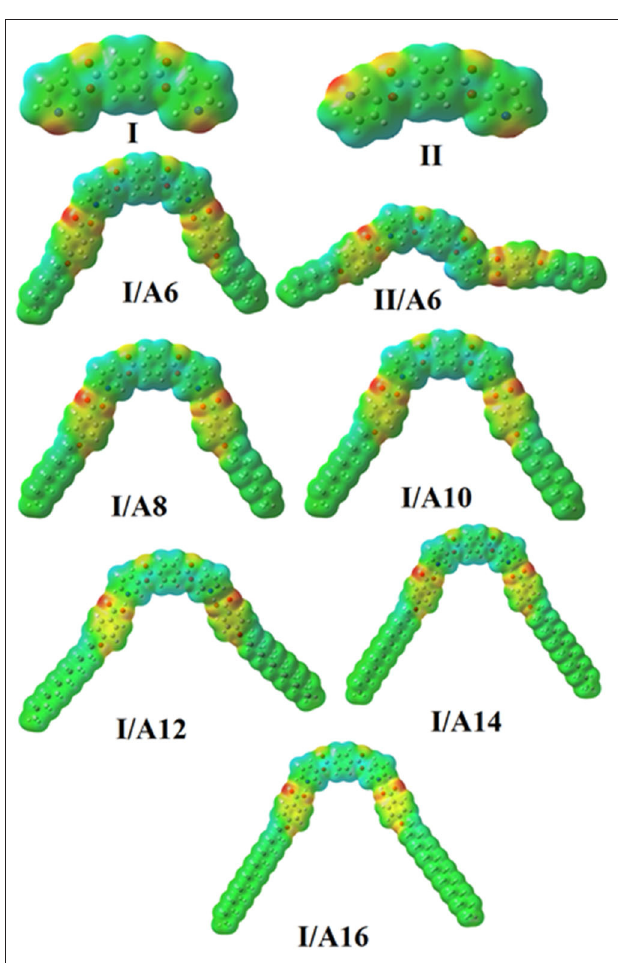
FIGURE 11 | Molecular electrostatic potentials (MEP) for investigated